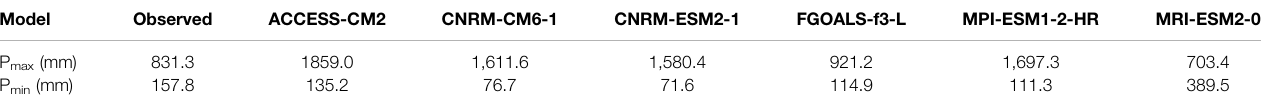
TABLE 5 | Maximum and minimum average annual precipitation of the grids simulated by the observed and the six higher-scoring GCMs over the Yellow River Basin. Model